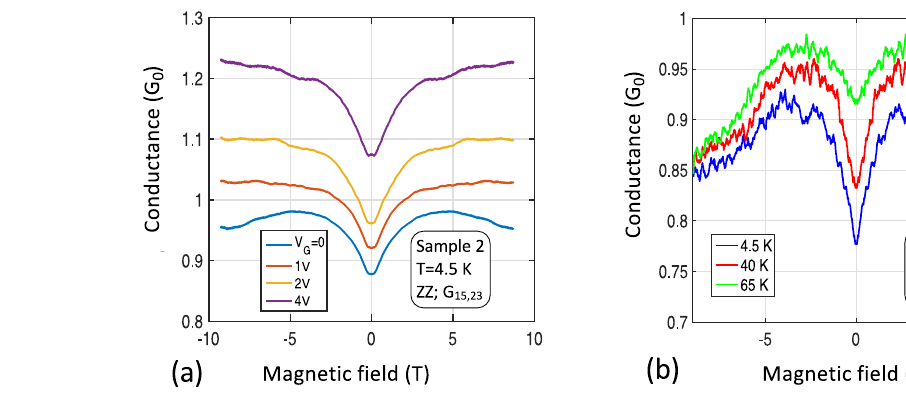
1,Seg. B atCNPfor3temperatures,whichshowsthattheconductancedipvanishes with increasing temperature. These properties suggest coherent scattering of the edge state at the junctions as explained in the text.